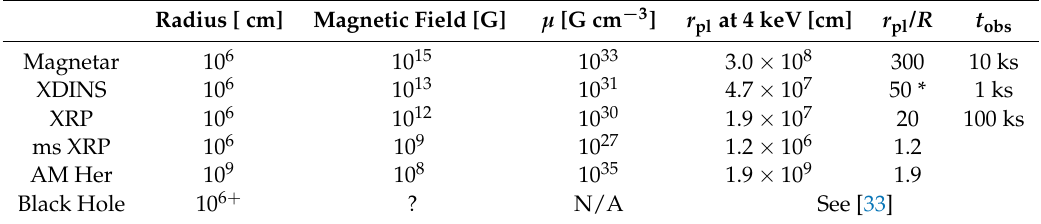
Figure 2. The polarized emission map of a neutron star overlaid on the apparent image of the NS. The left panel depicts the observed map of polarization directions if one assumes that the surface emits only in the ordinary mode (parallel to the local field direction) and neglects the vacuum birefringence induced by QED. The right panel shows the polarization map including birefringence for a frequency of ν = ( µ / ( 10 30 G cm 3 )) − 2 10 17 Hz. The ellipses and short lines describe the polarization of a light ray originating from the surface element beneath them. The lines and the major axes of the ellipses point towards the direction of the linear component of the polarization direction. The minor to major axis ratio provides the amount of circular polarization ( s 3 ). In both maps, the large dashed curves are lines of constant magnetic latitude (separated by 15 ◦ ). The observer’s line of sight makes an angle of 30 ◦ with the dipole axis. For comparison, if one assumes that the entire surface is emitting fully polarized radiation, the net linear polarization on the left 13% while it is 70% on the right. Table 1. The expected polarization-limiting radii for various sources; the typical observing times are for eXTP at 2–8 keV for the magnetars (4U 0142+61) and XRPs (Her X-1) from the text and for RedSOX [34] at 0.2–0.8 keV for RX J1856.5-3754 to make a four-sigma